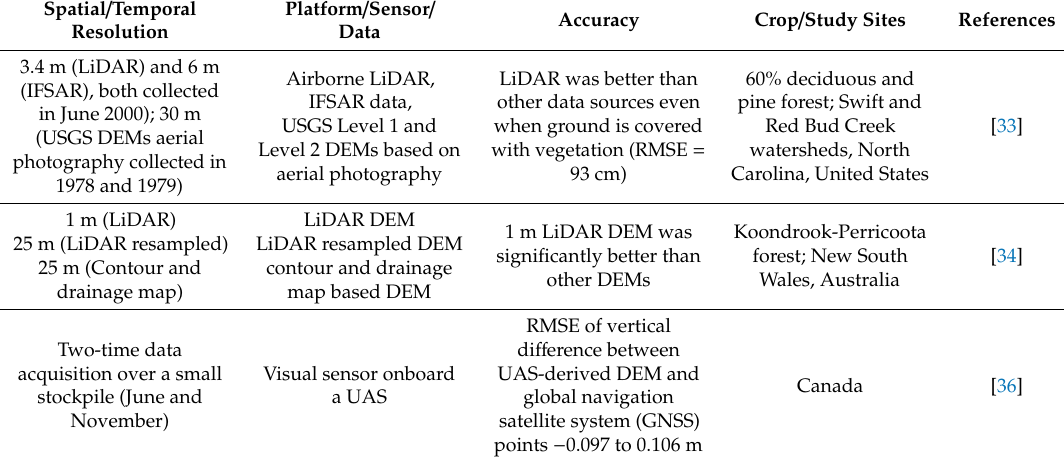
Table 1. Topography mapping using RS data from multiple